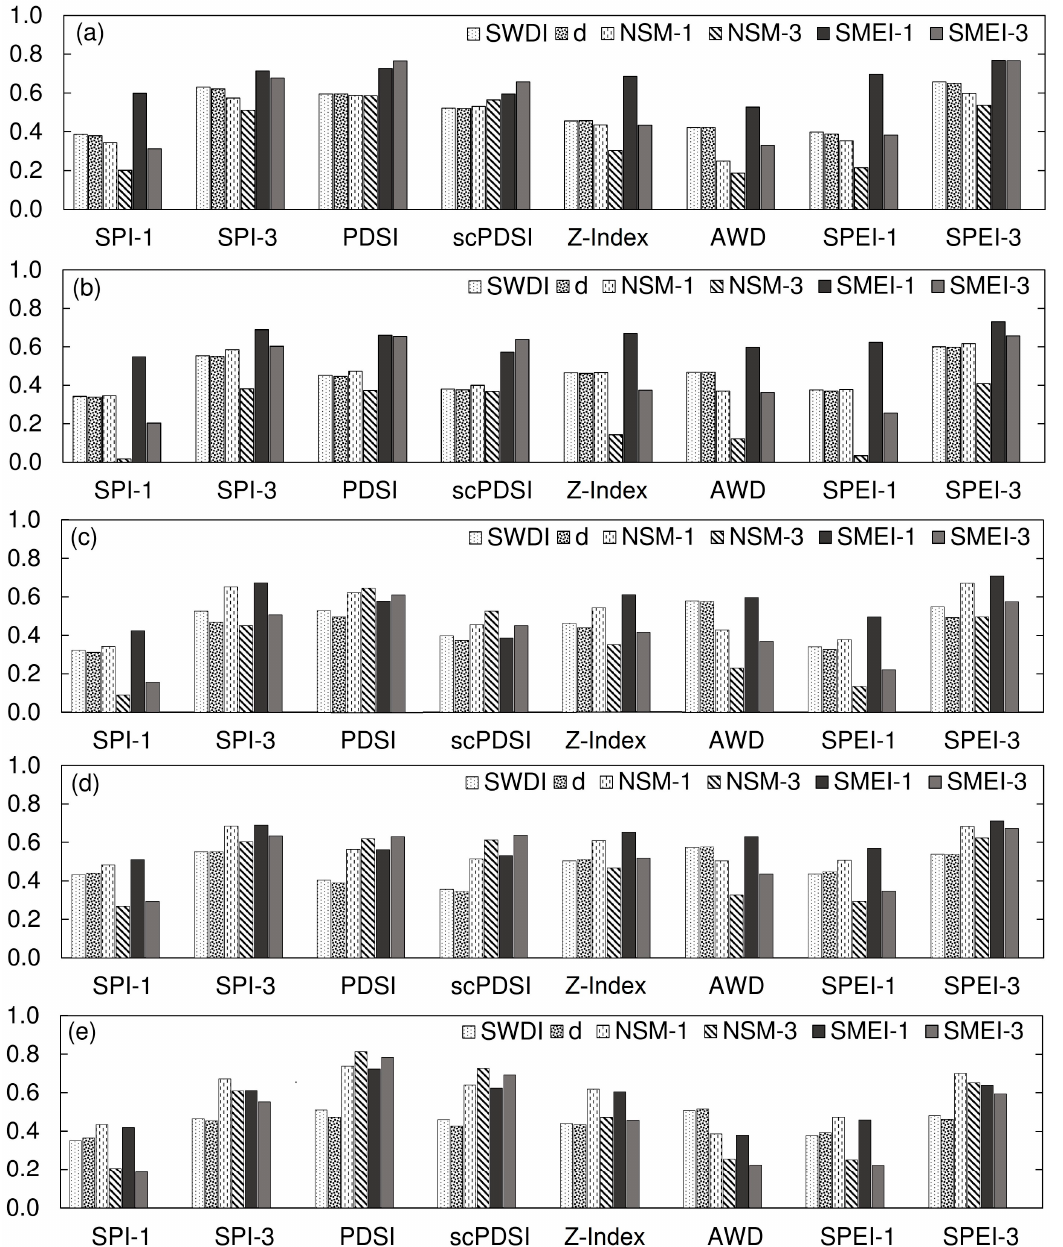
Figure 3. Correlation coe ffi cients among soil moisture based and meteorological drought indices at Goodwell ( a ); Hollis ( b ); El Reno ( c ); Pawnee ( d ); and Wister ( e